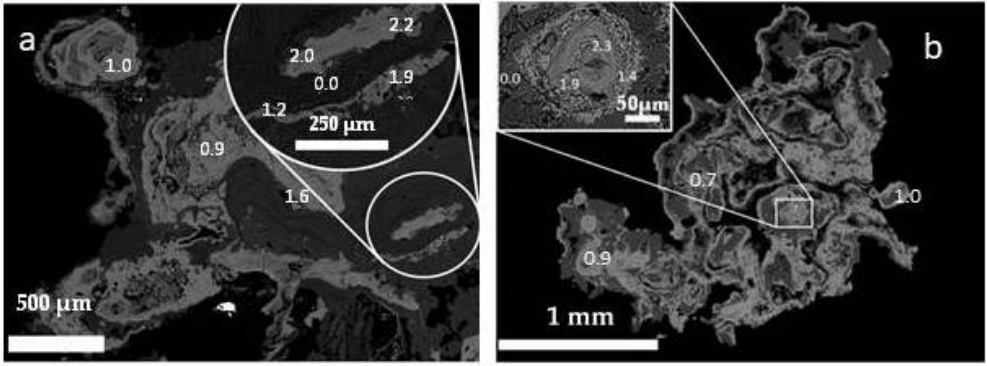
Figure 4. Examples of fluorine distribution in the oxalate-bearing stones, Samples 1703 ( a ) and 1384 ( b ). BSE images.